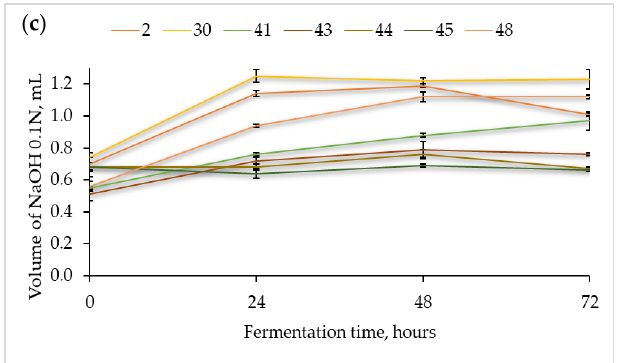
Figure 1. Acidification capacity (average ± standard deviation), measured in triplicate as total titratable acidity (TTA) of the selected presumptive Lactic Acid Bacteria when cultivated in sterile flour extracts of ( a ) chickpea, ( b ) quinoa, and ( c ) buckwheat at 37 °C for 72 h.